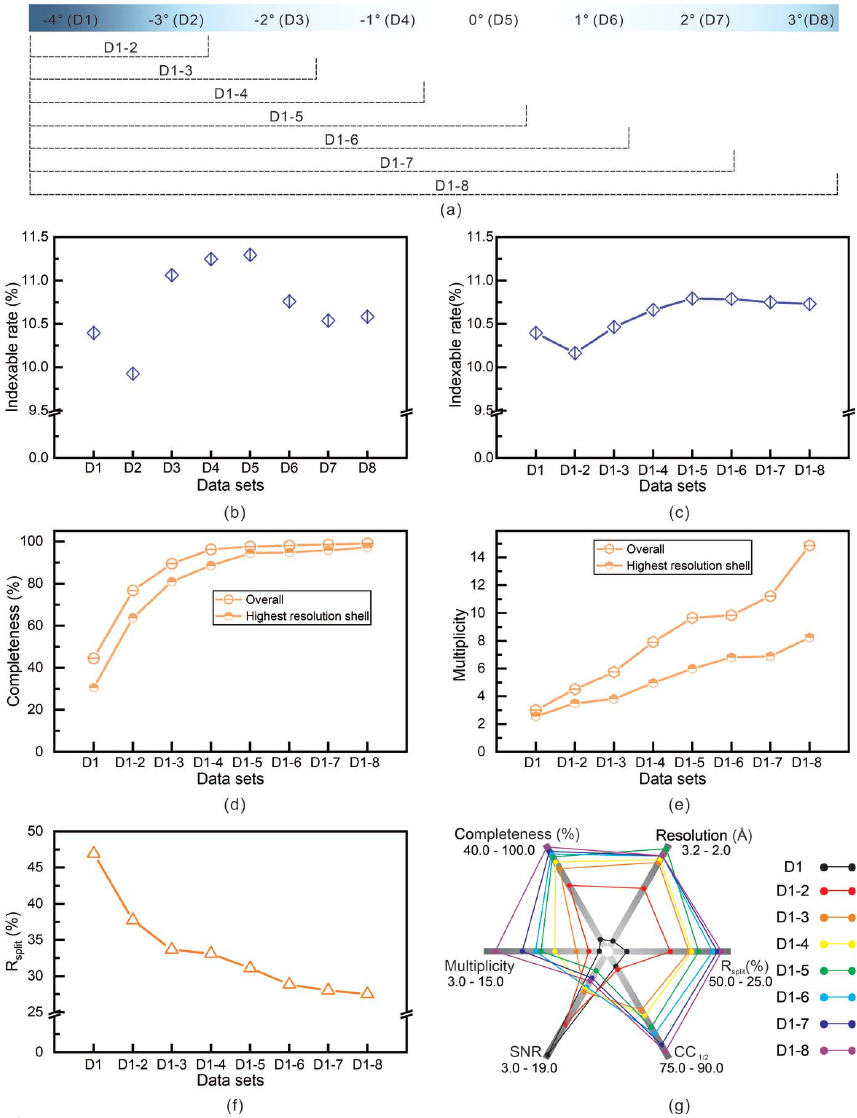
Figure 5 Data collection analysis. ( a ) Strategy of subset grouping. ( b ) Indexable rate of different subsets. ( c ) Indexable rate changes as the diffraction data accumulated. Changes in the figures of merit: ( d ) completeness, ( e ) multiplicity and ( f ) R split of the different subsets as the diffraction data accumulated. ( g ) Radar graph of the different subsets plotted by the different figures of merit. The scale of the axis is from the inside to the